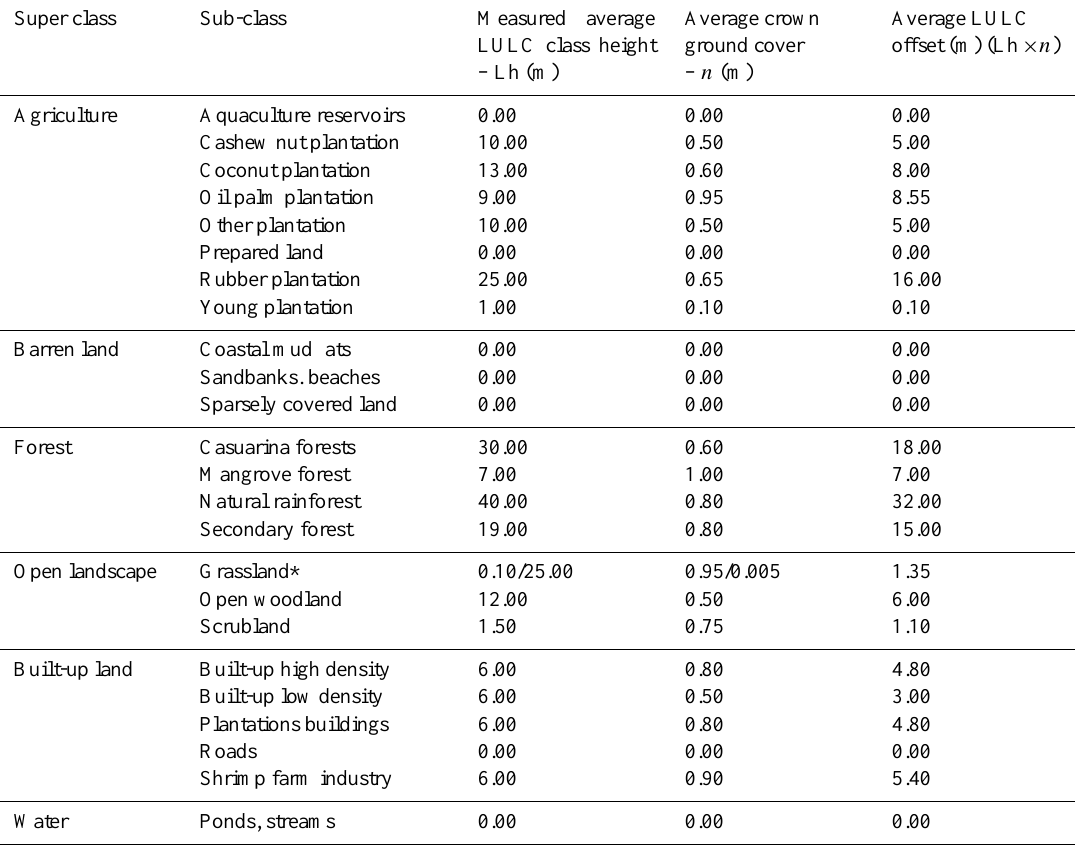
Table 2. LULC class heights and ground coverage derived from field measurements at the Phang Nga coast. The last column included the calculated LULC class offset to be subtracted from the original SRTM